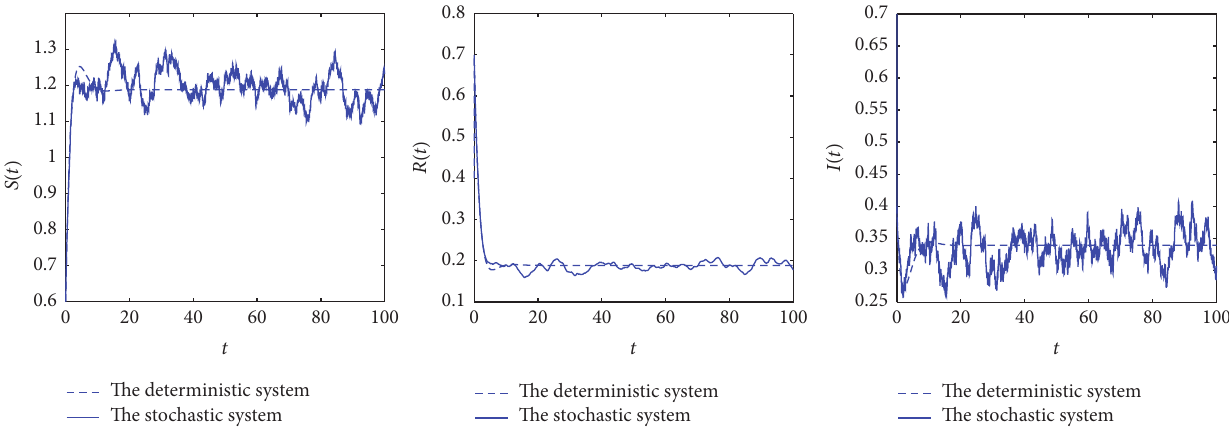
Figure 4: Simulations of the path 𝑆(𝑡) , 𝐼(𝑡) , 𝑅(𝑡) for the corresponding deterministic system (2) and stochastic system (4) with initial value (𝑆(0),𝐼(0), 𝑅(0)) = (0.6, 0.4, 0.5) , 𝜎 = 0.06 . and then by Theorems 2, with any initial value (𝑆(0), 𝐼(0), 𝑅(0)) = (0.6, 0.4, 0.5) ∈ Γ , we get that the solution of system (4)